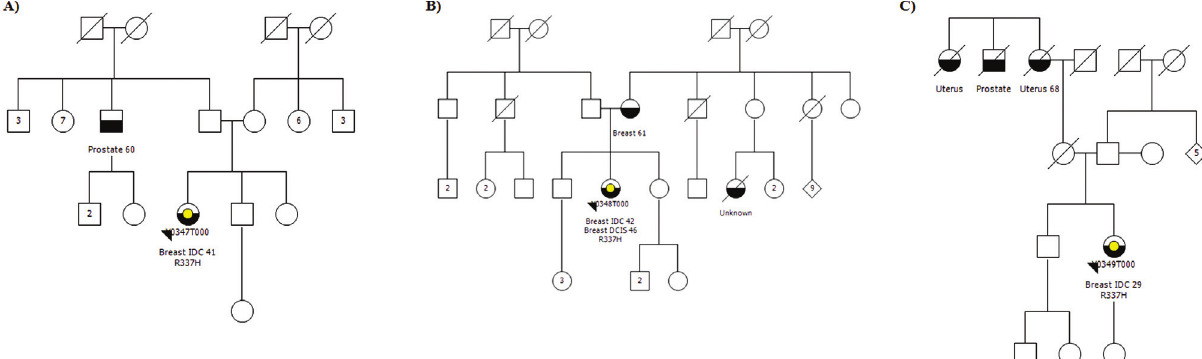
Figure 1 - Pedigrees of the families affected by the germline TP53 p.R337H mutation. A) Family Y0347, B) Family Y0348, C) Family Y0349. The proband is indicated by an arrow; black symbol: patient affected by malignant tumor; yellow symbol: patient carrier of the p.R337H mutation; first infor- mation below the symbol: type of tumor and age at